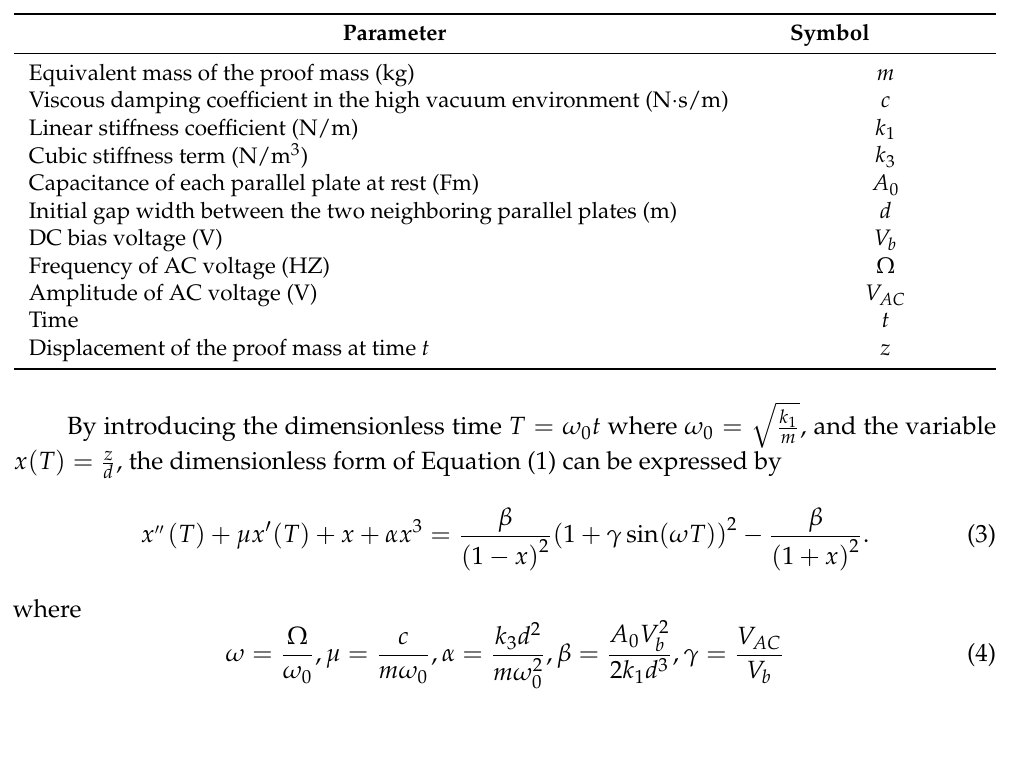
Table 1. Parameters of systems (1) and